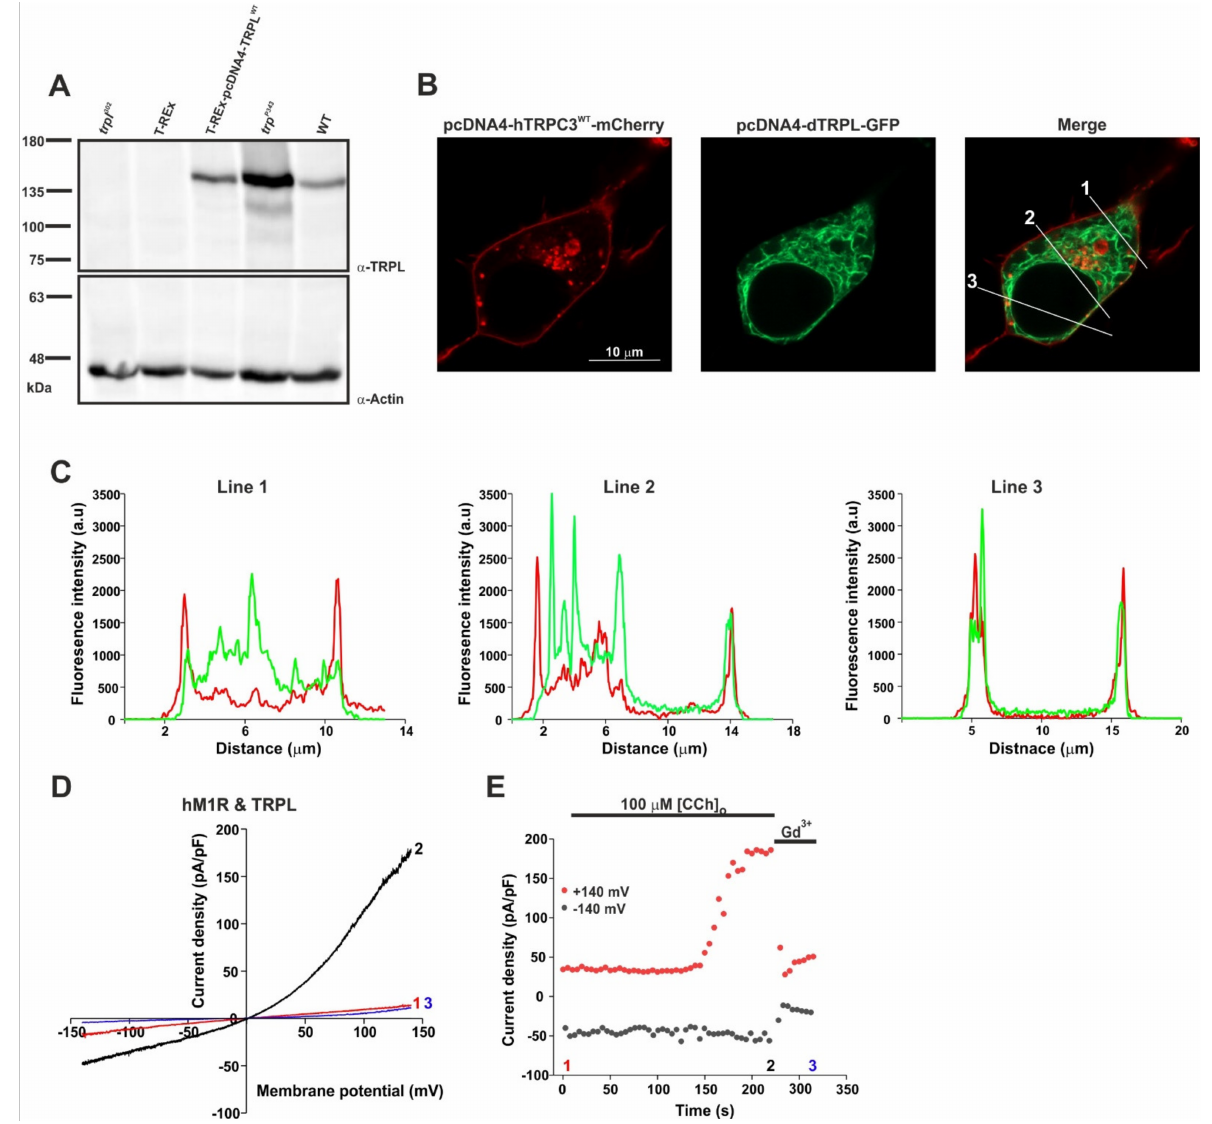
Figure 1. Heterologous expression, localization, and activation of the TRPL channel in HEK cells. ( A ) Western-blot analysis of T-REx-293 cells expressing dTRPL WT (third lane), using α -dTRPL anti- body. The Drosophila trpl 302 mutant fly heads lacking the TRPL channel (first lane) and un-transfected T-REx cells (second lane) were used as negative controls. The Drosophila trp P 343 mutant fly heads expressing only the TRPL channel (fourth lane), and the Drosophila WT fly heads (fifth lane) were used as positive controls. α -Actin antibody was used as protein loading control ( n = 4). Molec- ular mass marker (in kDa) is indicated to the left of the gel. ( B ) Representative confocal fluores- cence images of Naïve T-REx-293 cells co-transfected with hTRPC3 WT -mCherry (red, left) and with dTRPL-GFP (green, middle). The right image shows the merged localization of hTRPC3 WT -mCherry together with dTRPL WT -GFP. Scale bar 10 µ m (applicable for all three images). The three lines crossing the cell (1, 2, 3) indicate the location of the analysis performed in section C. The total number of analyzed cells is 12. ( C ) Line profile graphs of the fluorescent intensity along the three white lines crossing the plasma membrane in the right merged image (1, 2, 3). The red graph repre- sents hTRPC3 WT -mCherry expression, and the green graph represents dTRPL WT -GFP expression. ( D ) Representative current–voltage relationship (i-V curves) obtained from patch clamp whole cell current measurements from a T-REx-293 cell heterologously expressing dTRPL WT , GFP and the human Muscarinic Receptor 1 (hM1R) in response to voltage ramps from − 150 mV to +150 mV (in 1 s), before bath application of carbachol (CCh, red, 1), after application of 100 µ M CCh (black, 2) and